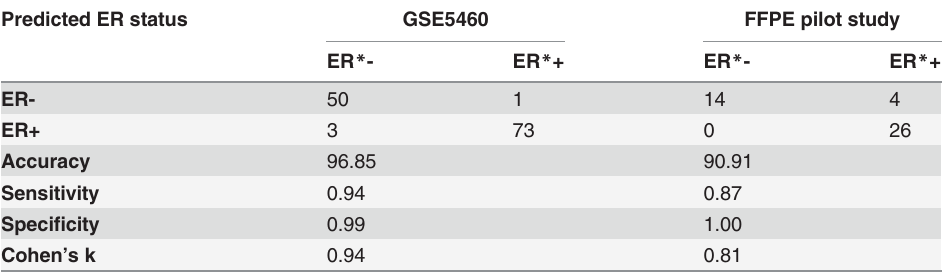
Table 1. Performance of the ER